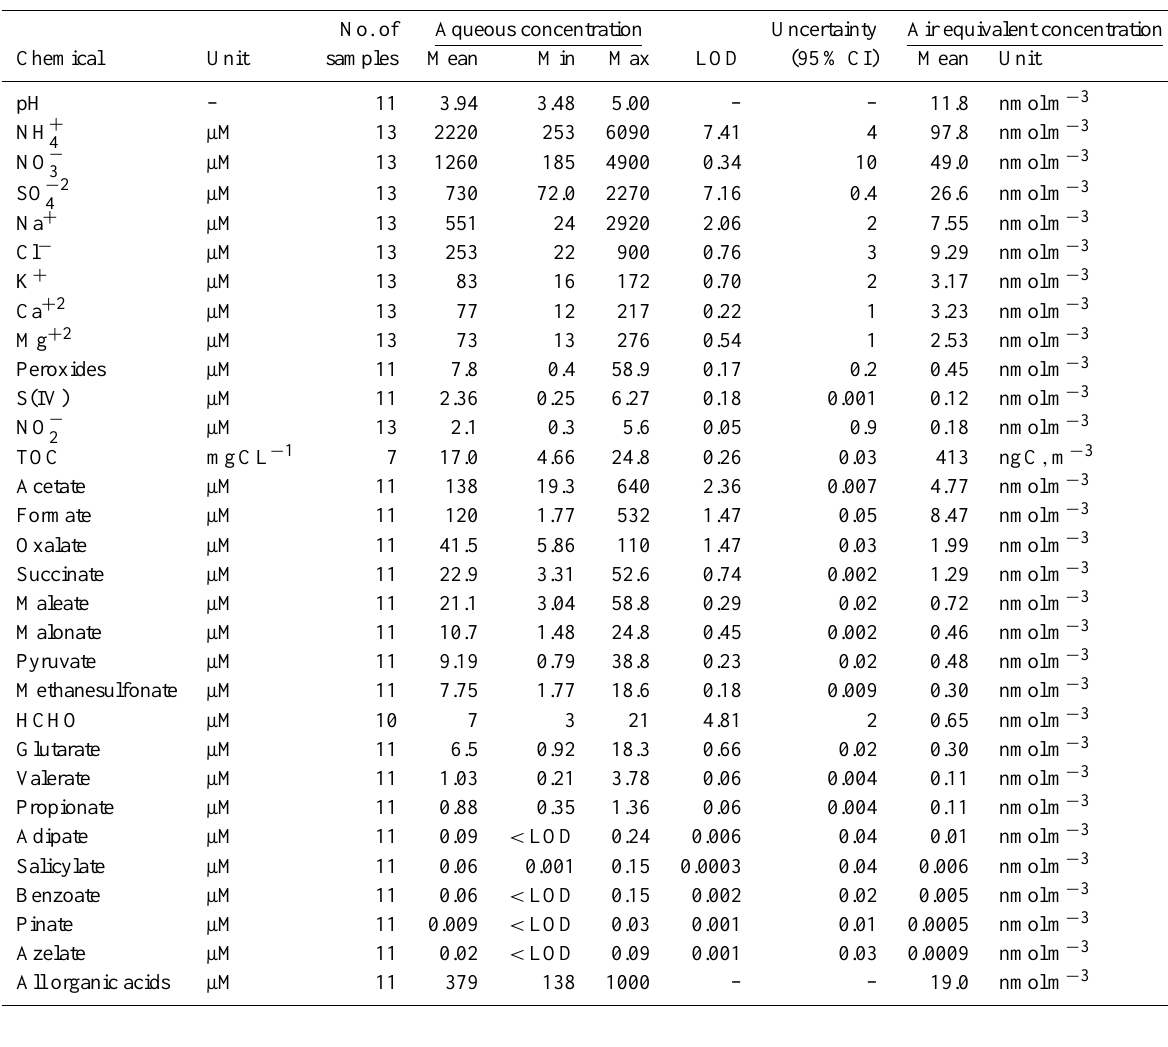
Table 1. Mean, minimum, and maximum concentrations of organic and inorganic species quantified in fog samples collected at BYI. Values below the LOD are shown in